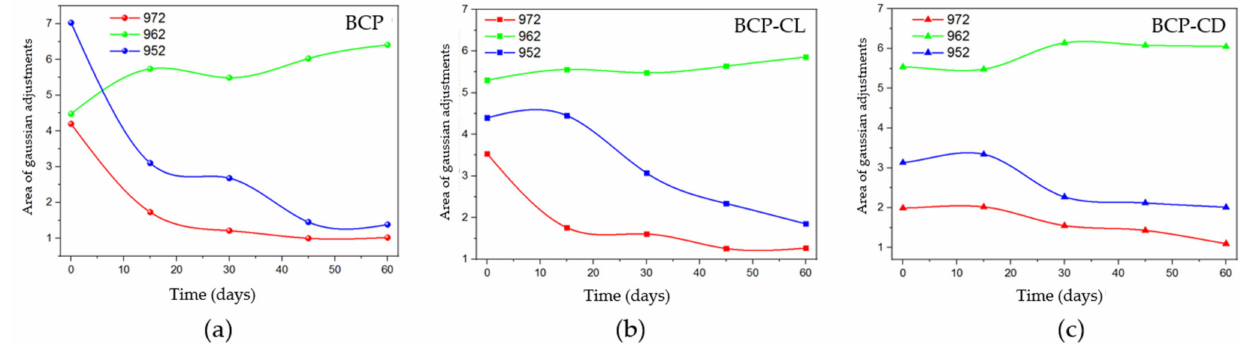
Figure 11. Behavior of the areas of the adjusted bands in the Micro-Raman analysis as a function of the analyzed periods, being the band 962 cm − 1 referring to HAp and the bands 972 cm − 1 and 952 cm − 1 referring to β -TCP. ( a ) BCP, shows the most evident decay in the first 15 d of study of the bands related to β -TCP; ( b ) BCP-CL and ( c ) BCP-CD show that the bands related to β -TCP did not present evident decay in the first 15 d, but slow throughout the 60 d of